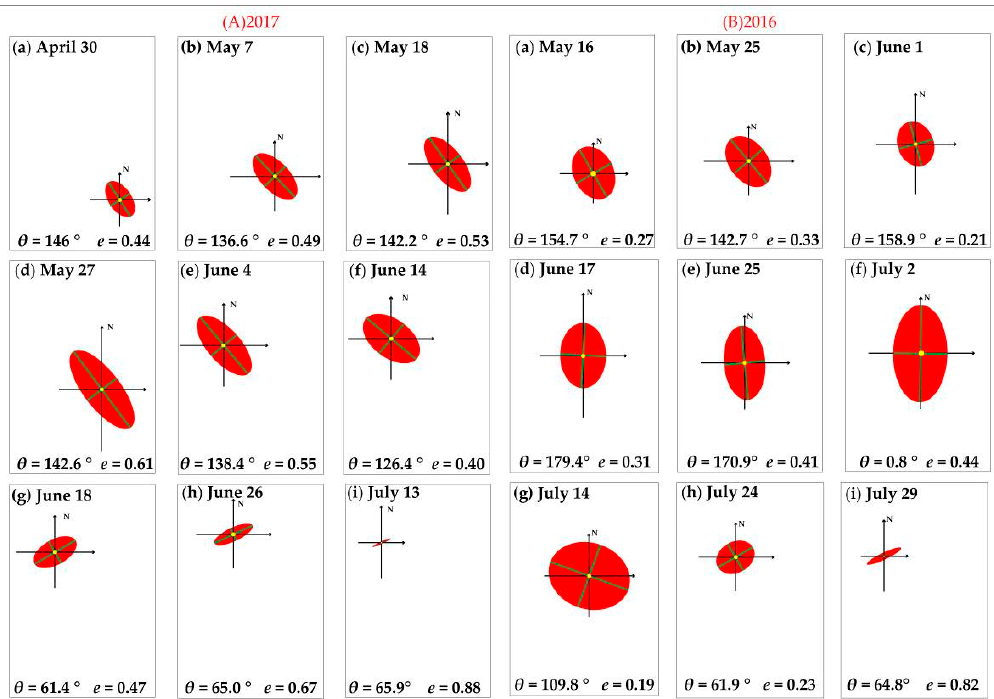
Figure 10. ( A ) Standard deviation ellipse of the coverage area of U. prolifera in 2017: ( a ) The SDE on April 30; ( b ) The SDE on May 7; ( c ) The SDE on May 18; ( d ) The SDE on May 27; ( e ) The SDE on June 4; ( f ) The SDE on June 14; ( g ) The SDE on June 18; ( h ) The SDE on June 26; ( i ) The SDE on July 13. ( B ) Standard deviation ellipse of the coverage area of U. prolifera in 2016: ( a ) The SDE on May 16; ( b ) The SDE on May 25; ( c ) The SDE on June 1; ( d ) The SDE on June 17; ( e ) The SDE on June 25; ( f ) The SDE on July 2; ( g ) The SDE on July 14; ( h ) The SDE on July 24; ( i ) The SDE on July 29.